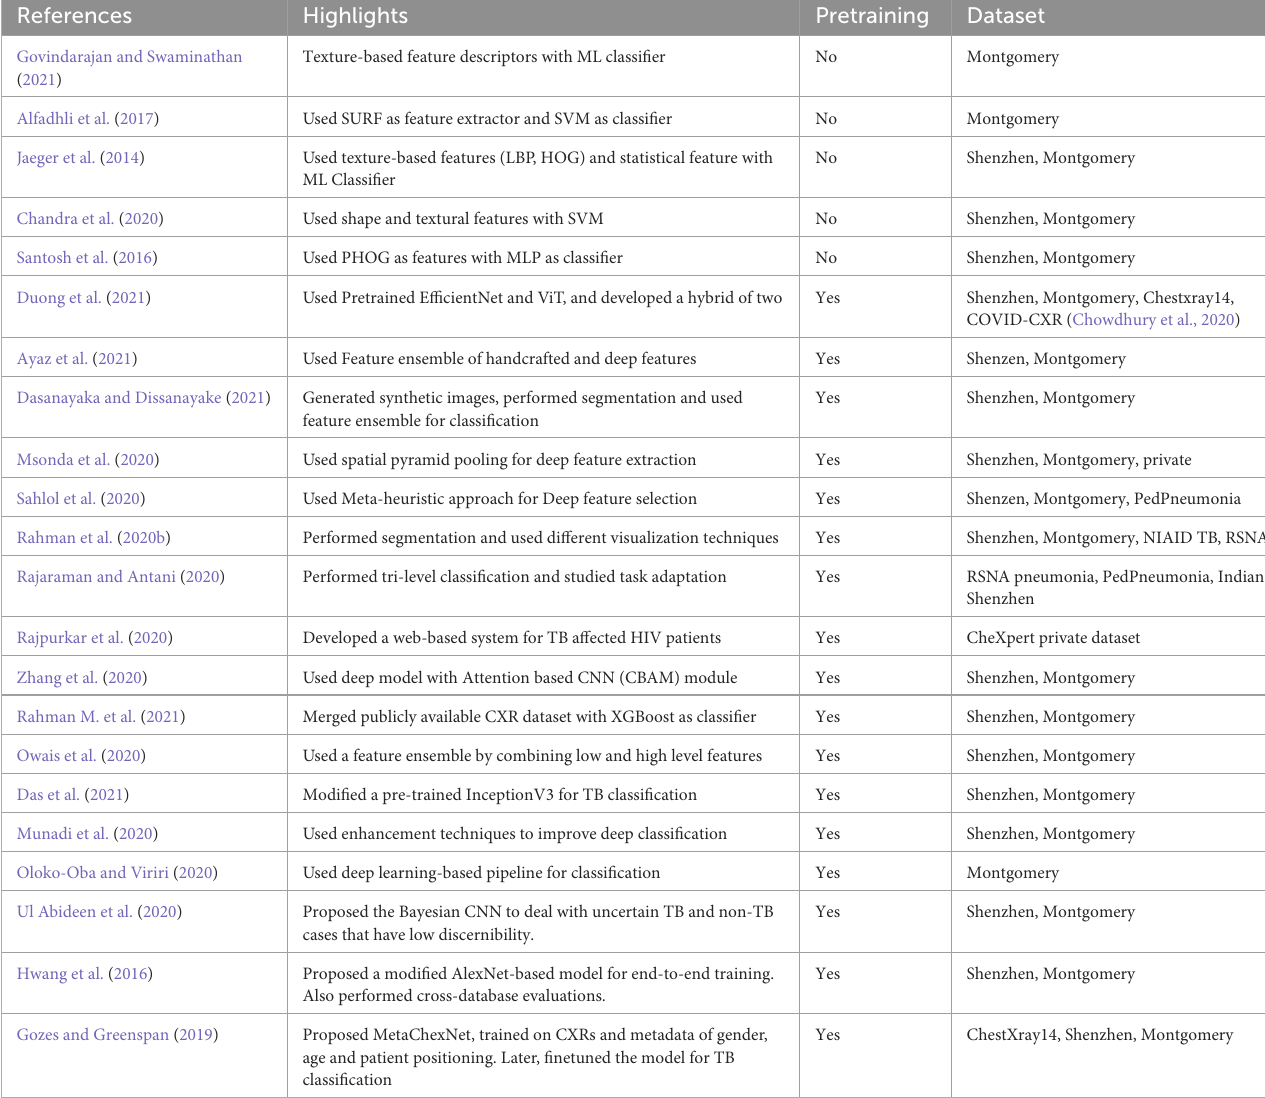
TABLE 3 Review of the literature for TB detection using CXRs based on different feature extraction